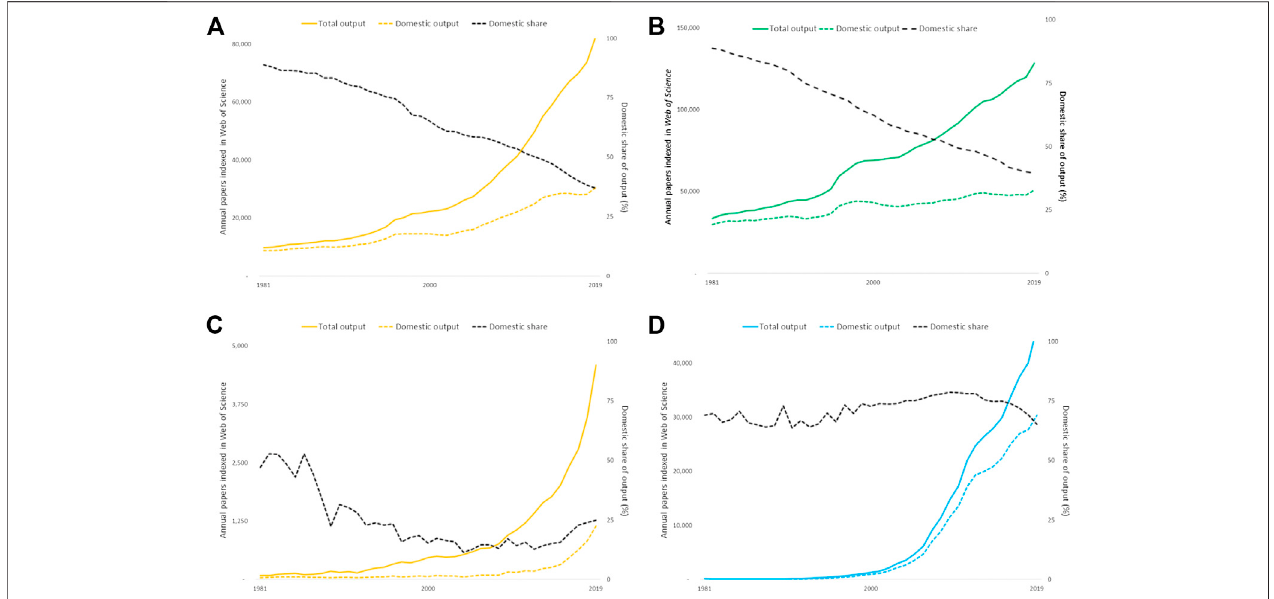
Figure 5 | (A) – (D) Output indexed on the Web of Science for Australia, Germany, Indonesia and Iran deconstructed by total and purely domestic articles and reviews. The domestic share of output has steadily declined for the large research economies while output, boosted by collaboration, has steadily risen. Output for the smaller economies has risen more steeply but the pro fi le of international collaboration is less consistent. (A) Australia (B) Germany. (C) Indonesia (D) Iran.